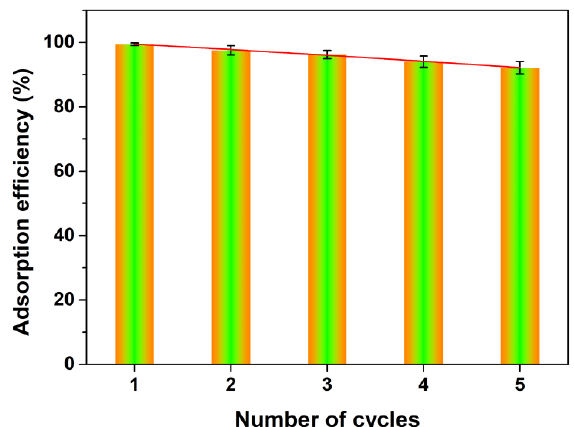
Figure 12. Adsorbent regeneration times on the adsorption efficiency of porous CeO 2 ([CeO 2 ] = 2.0 g/L; [AO7] = 100 mg/L; V = 100 mL; 200 rpm; Room temperature; No pH preadjustment). [AO7] = 100 mg/L; V = 100 mL; 200 rpm; Room temperature; No pH